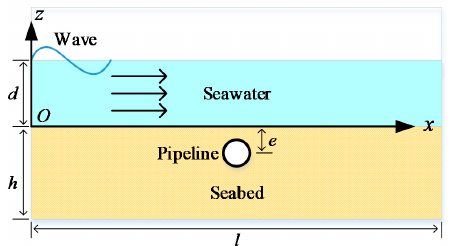
Figure 2 . Sketch of the wave–current–seabed–pipeline interactions. Figure 2. Sketch of the wave–current–seabed–pipeline